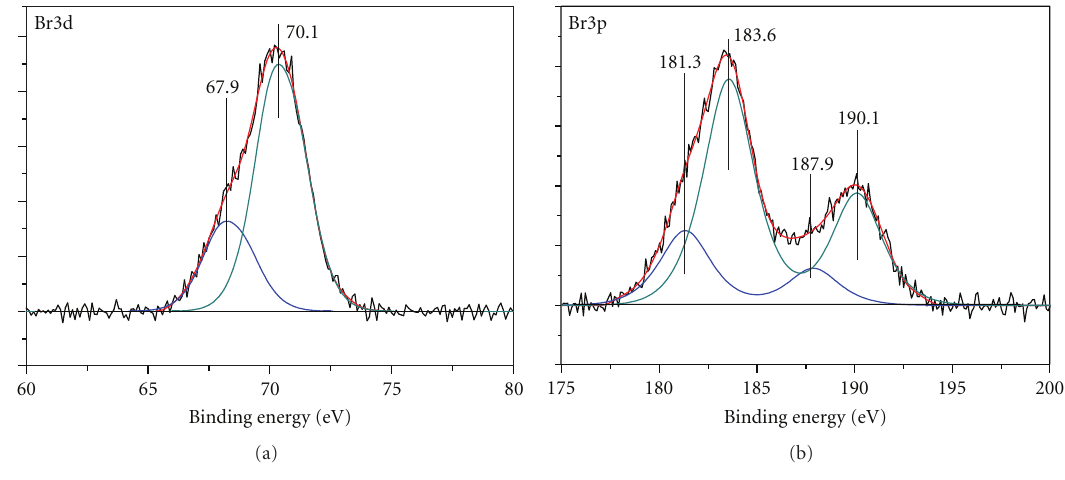
Figure 3: Decomposition of Br3d line (a) and Br3p line (b) for MWNT Br sample.